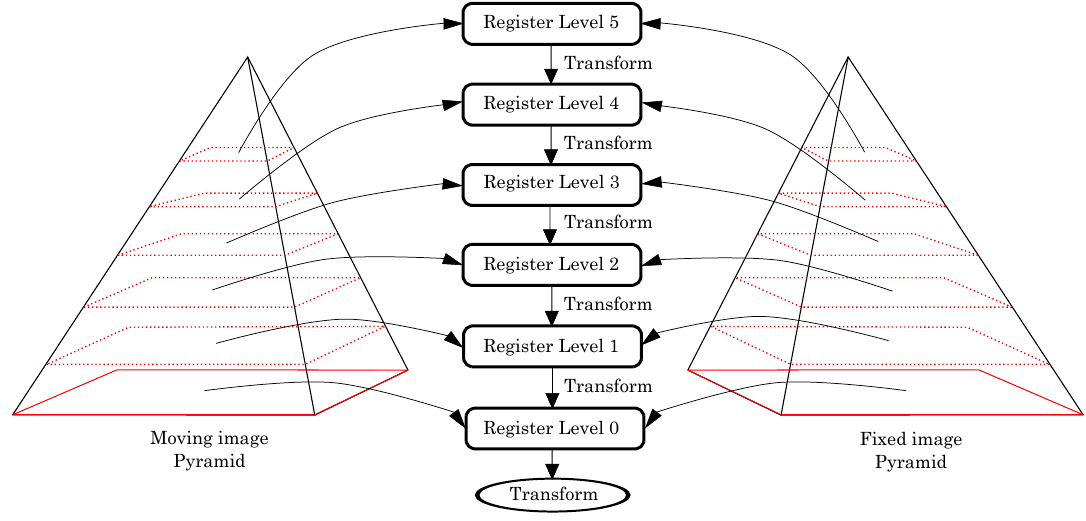
Figure 2. Pyramidal process employed in